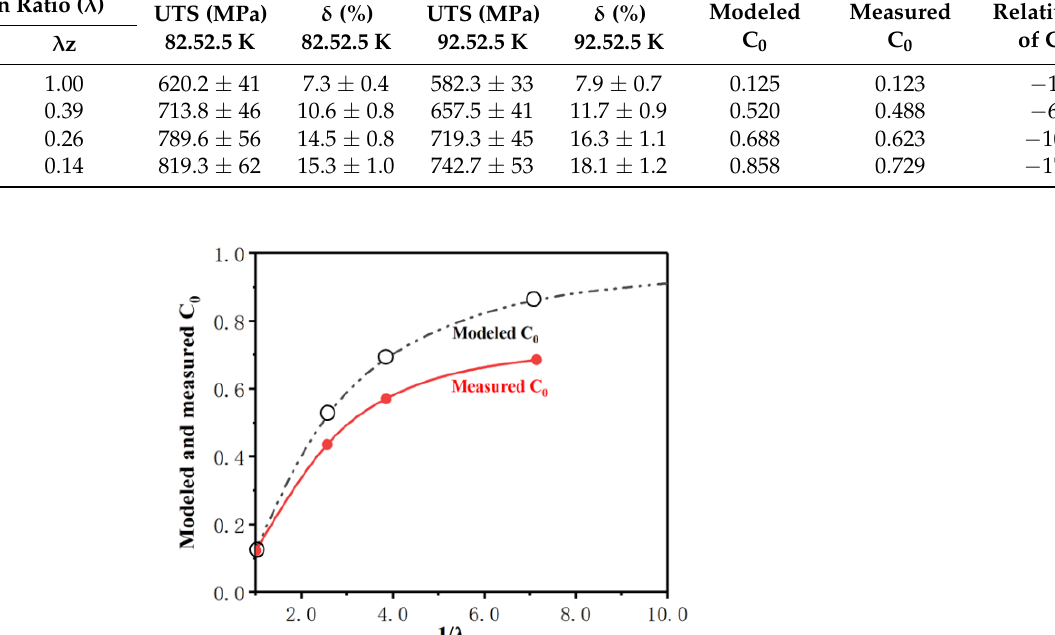
Table 1. Mechanical properties and the C 0 values of the composite after thermal processing with different levels of deformation.